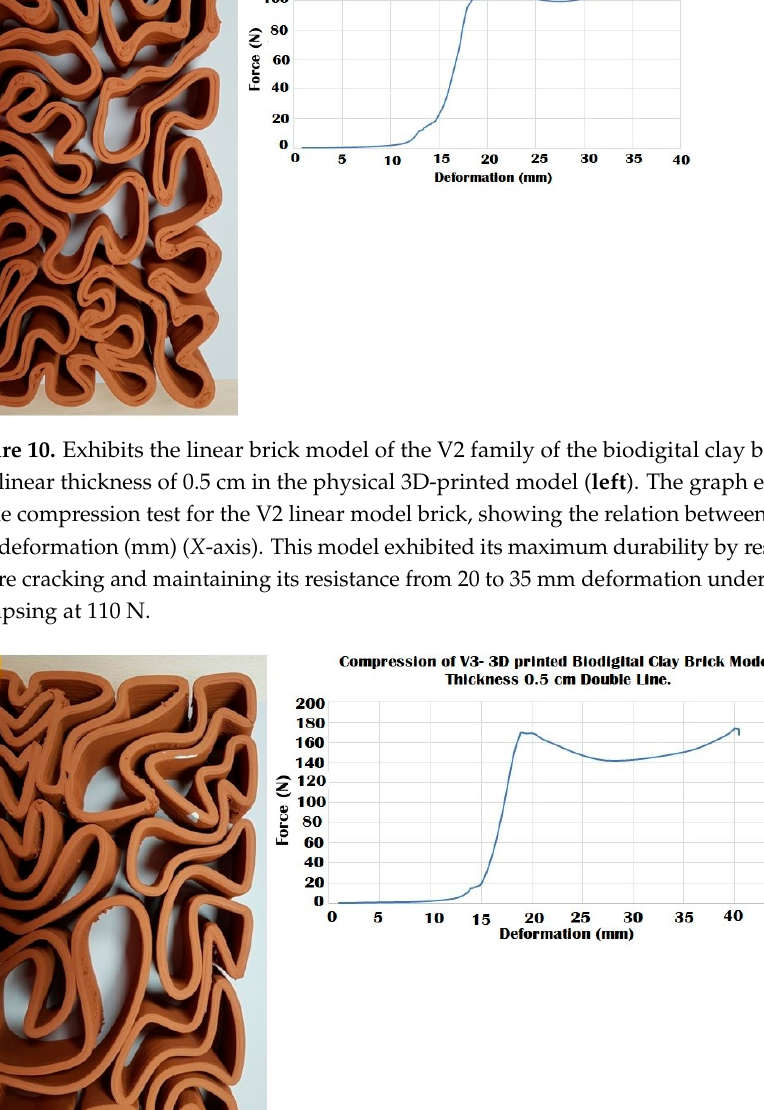
combined in load-bearing walls for enhanced durability and compression resistance.